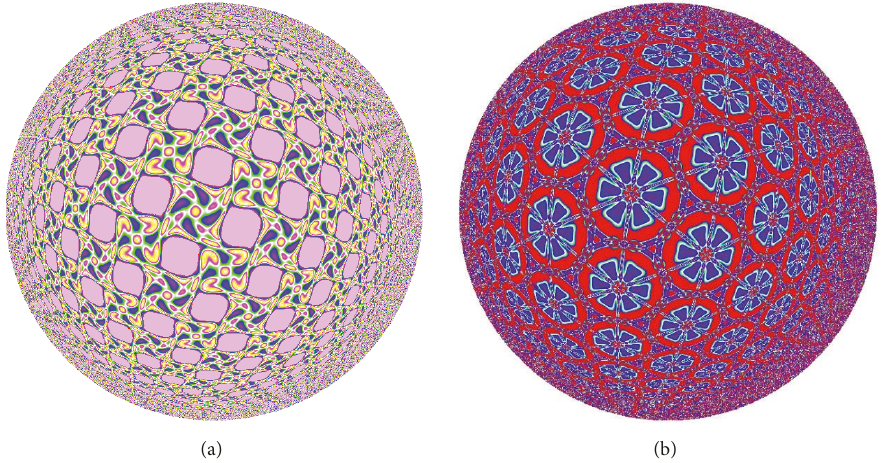
Figure 6: Colorful spherical wallpaper patterns with the 𝑝4 (a) and 𝑝6𝑚 (b) symmetry.